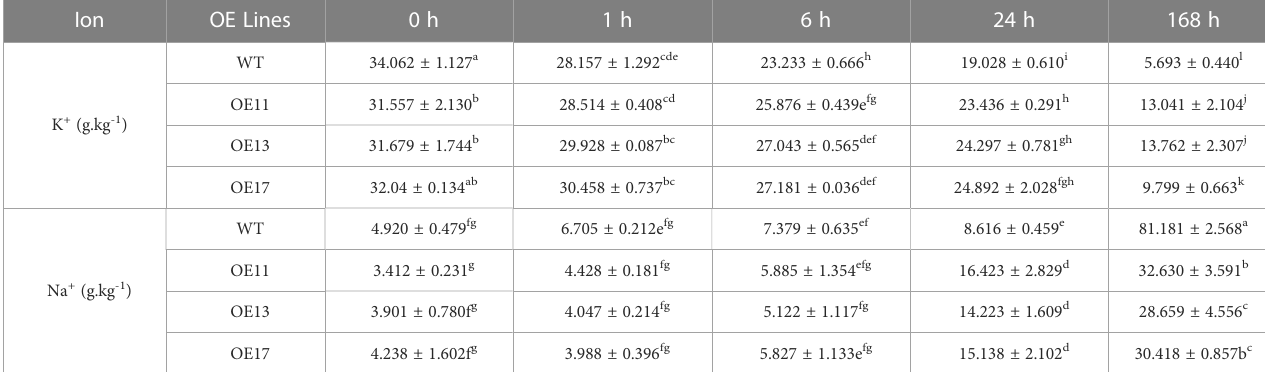
TABLE 2 K + and Na + content in leaves of CeqHAK11 overexpressing transgenic Arabidopsis and WT under different time periods of salt treatment.